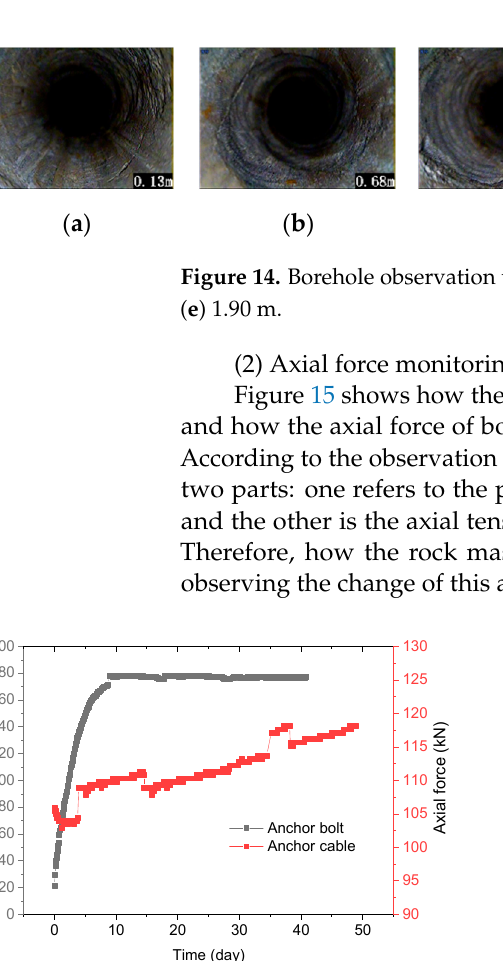
Figure 15. Axial force monitoring of bolts and cables. ( a ) Original scheme; ( b ) new scheme. After the pre-tightening operation is finished, the axial force of bolts in the original scheme is 48 kN. Then, the value surges to 178.22 kN and is finally stabilized at 177.25 kN, as shown in Figure 15a. The axial force of cables is 105.96 kN after this operation,